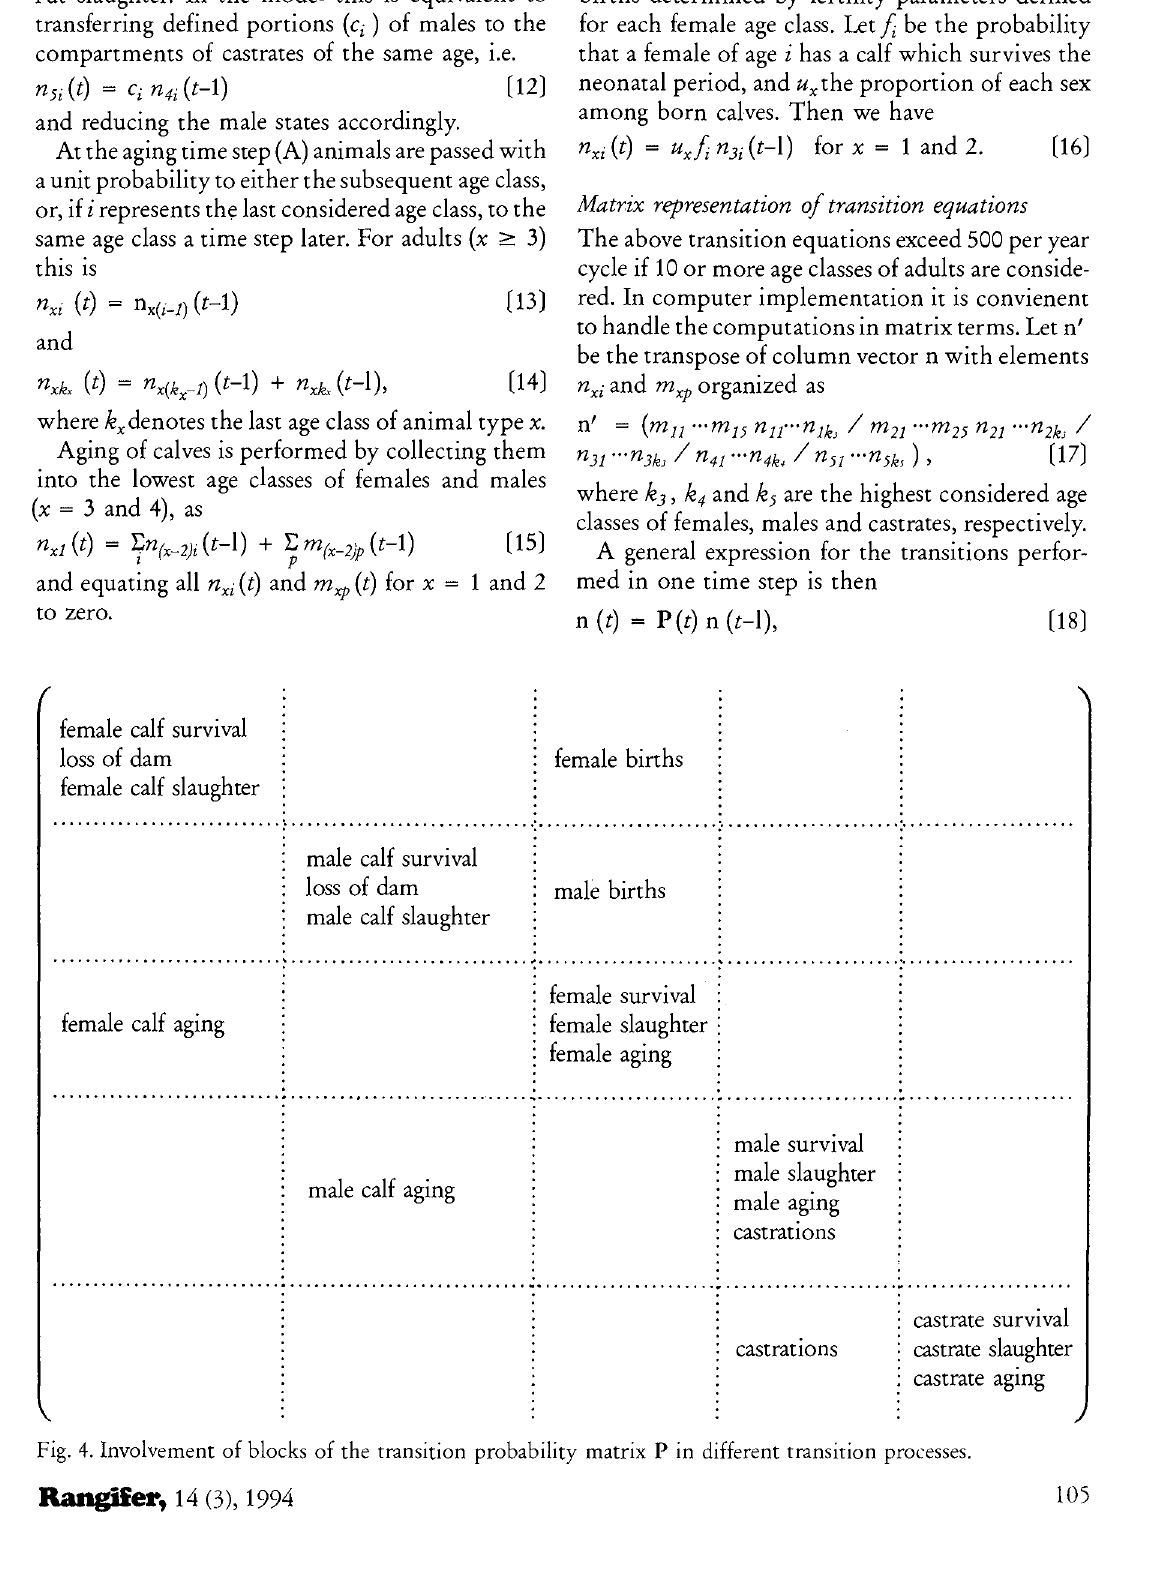
Fig. 4. Involvement of blocks of the transition probability matrix P in different transition